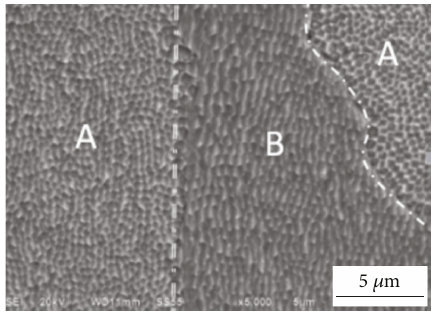
Figure 20: Representative SEM images at high magni fi cation showing the typical cellular structure observed in sample